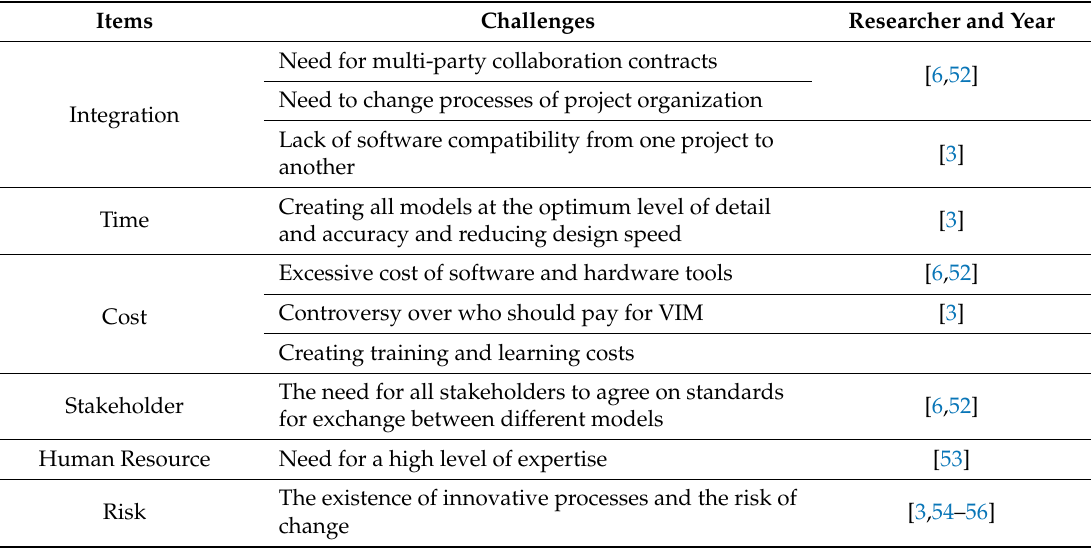
Table 2. Challenges of VIM